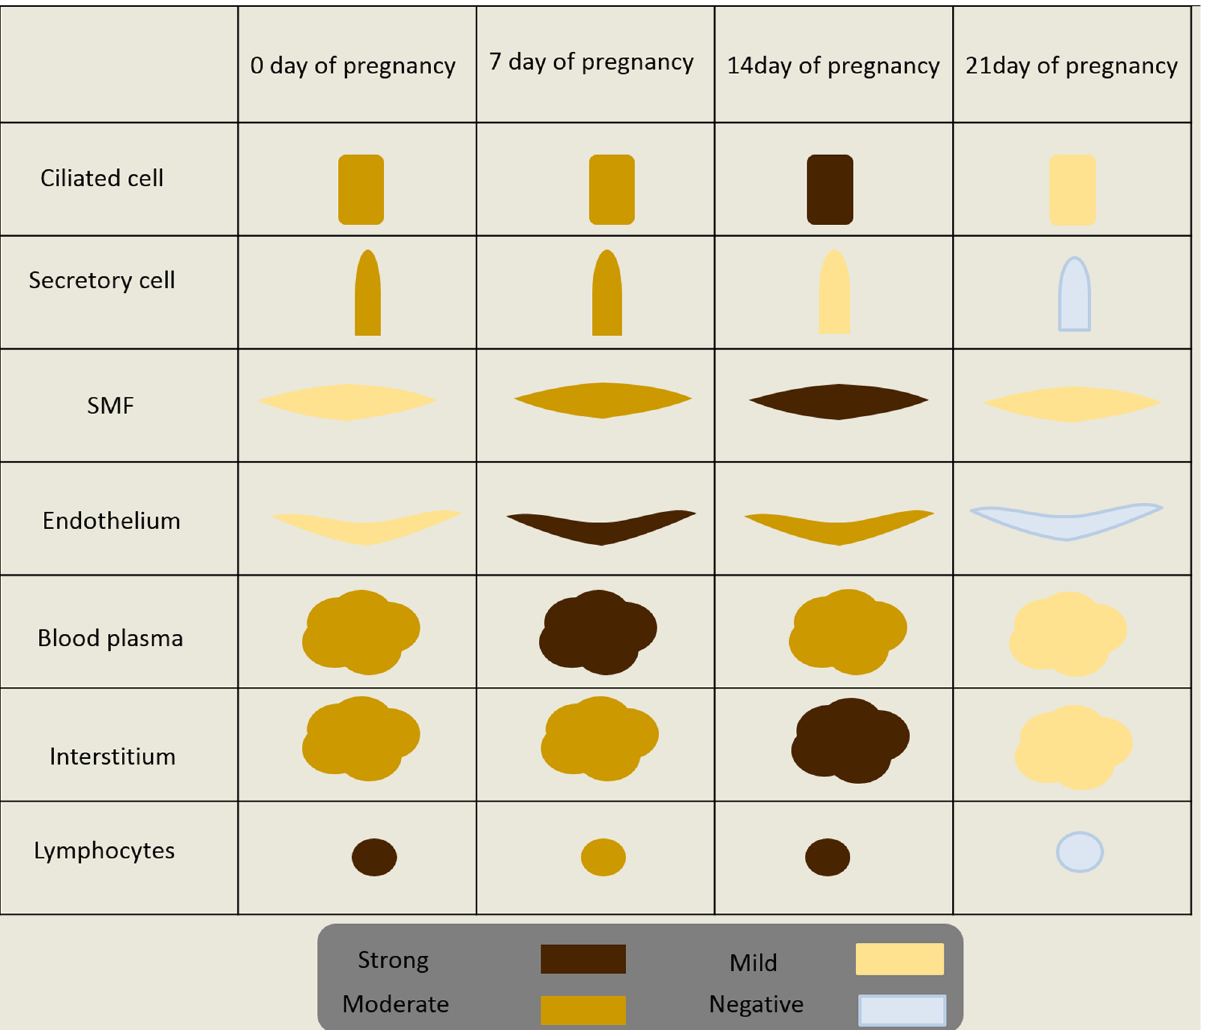
Figure 7. The intensity of the ERA immunoreaction at the different structural components of the cervix at different stages of pregnancy.